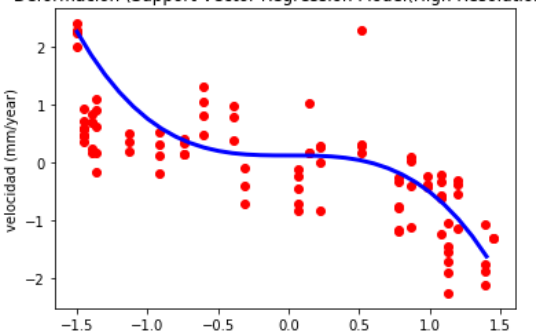
Figure 8 . Training values and the generated model, Support Vector Regression.